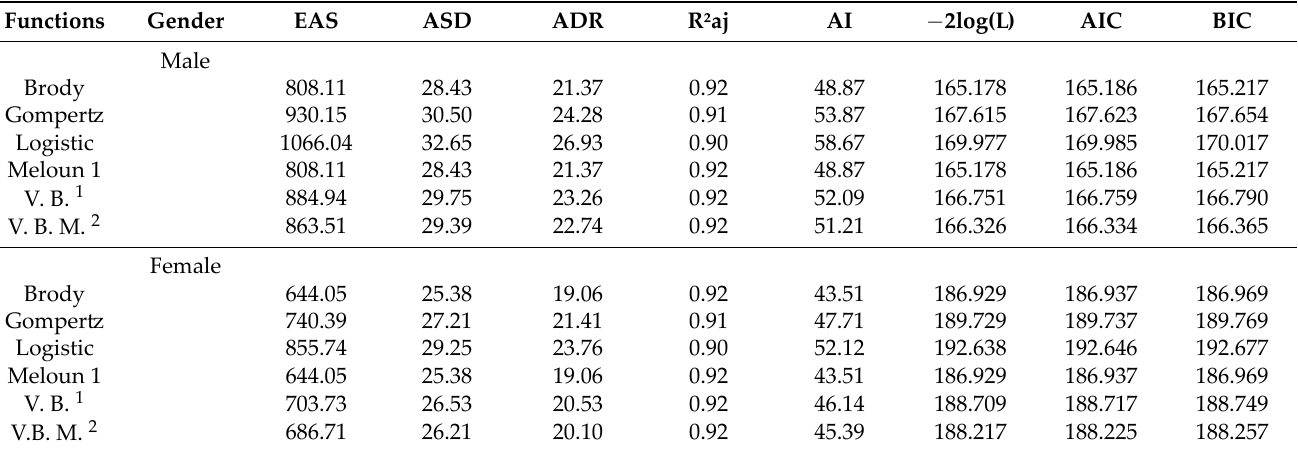
Table 4. Average square error estimates (ASE), asymptotic standard deviation (ASD), average de‑ viation of residual deviations (ADR), adjusted coefficient of determination (R²aj), asymptotic index (AI), minus two times the natural logarithm of the likelihood function 2log(L) Akaike information criterion (AIC), and Bayesian information criterion (BIC) for each gender and each